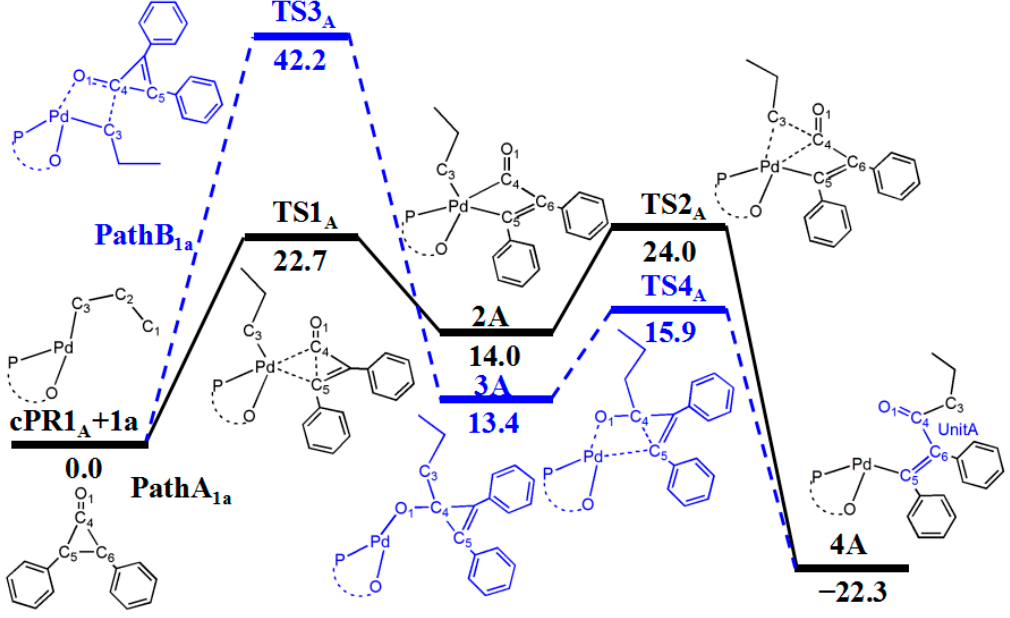
Figure 3. The reaction pathway of cyclopropenone, Path A 1a (black) and Path B 1a (blue); the relative free energy is given in kcal/mol.